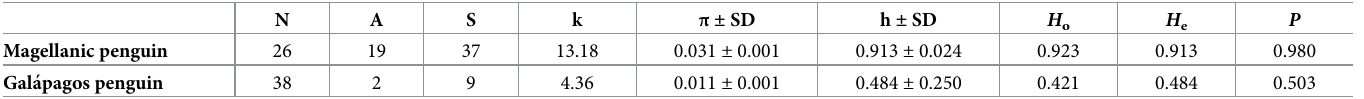
Table 1. Summary of genetic variation for MHC class II DR β 1 sequences in the Magellanic and Gala´pagos penguins. Number of samples (N), number of alleles (A), number of polymorphic sites (S), average number of nucleotide differences (k), nucleotide diversity ( π ), haplotype diversity (h), and observed ( H o ) and expected ( H e ) het- erozygosity are presented. P -values ( P ) are reported for tests of deviations from Hardy-Weinberg equilibrium. SD represents standard deviations.